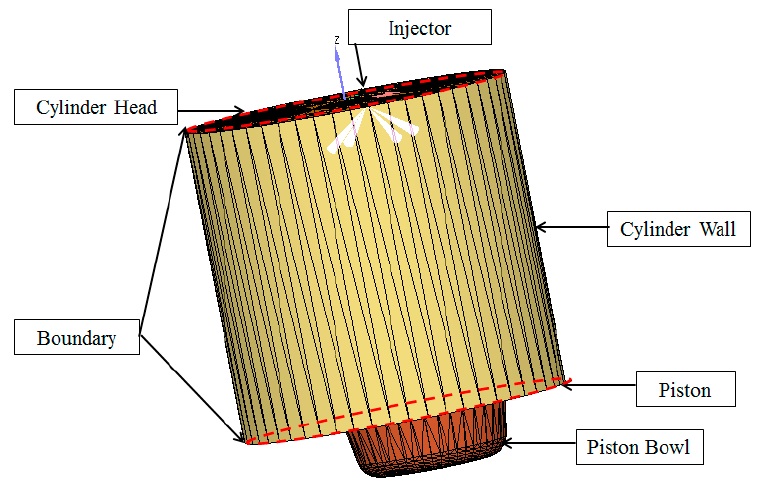
Figure 1. Yanmar TF90 combustion cylinder